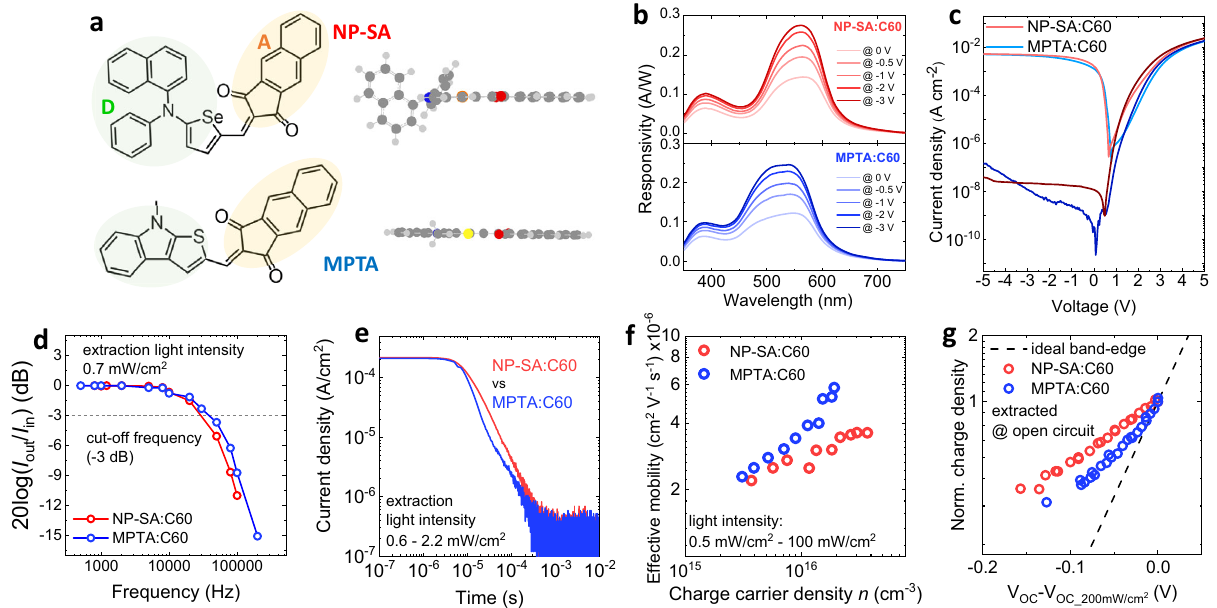
Fig. 1 OPD device characteristics at high-light intensity. a Molecular structure of NP-SA and MPTA donors, with their donor and acceptor units indicated. The spatial conformation of donor molecules is illustrated based on the DFT optimized geometries shown as side views. b The responsivity at different bias conditions. c Dark and AM1.5 G light J – V curves in a semi-log plot, shown with darker and brighter colors respectively. d The bandwidth of frequency response measured at a light intensity of 0.7 mW/cm 2 at 0 V. e Light-off photocurrent transient at the light intensity range of 0.6 – 2.2 mW/cm 2 illumination at 0 V, the device was illuminated for 100 ms before switching off the light, the background current level is higher than the dark current of the device due to the sensitivity limitation of the detector circuit (50 Ω load resistance, 1 mV/div of the oscilloscope). f Effective charge carrier mobilities as a function of charge carrier densities analyzed by charge extraction (CE) at 0 V at the light intensity range of 0.5 – 100 mW/cm 2 . g Normalized plots of the charge carrier density at open circuit versus open circuit voltage determined from integration of charge extraction transients as a function of light irradiation intensity (data normalized at 200 mW/cm 2 light